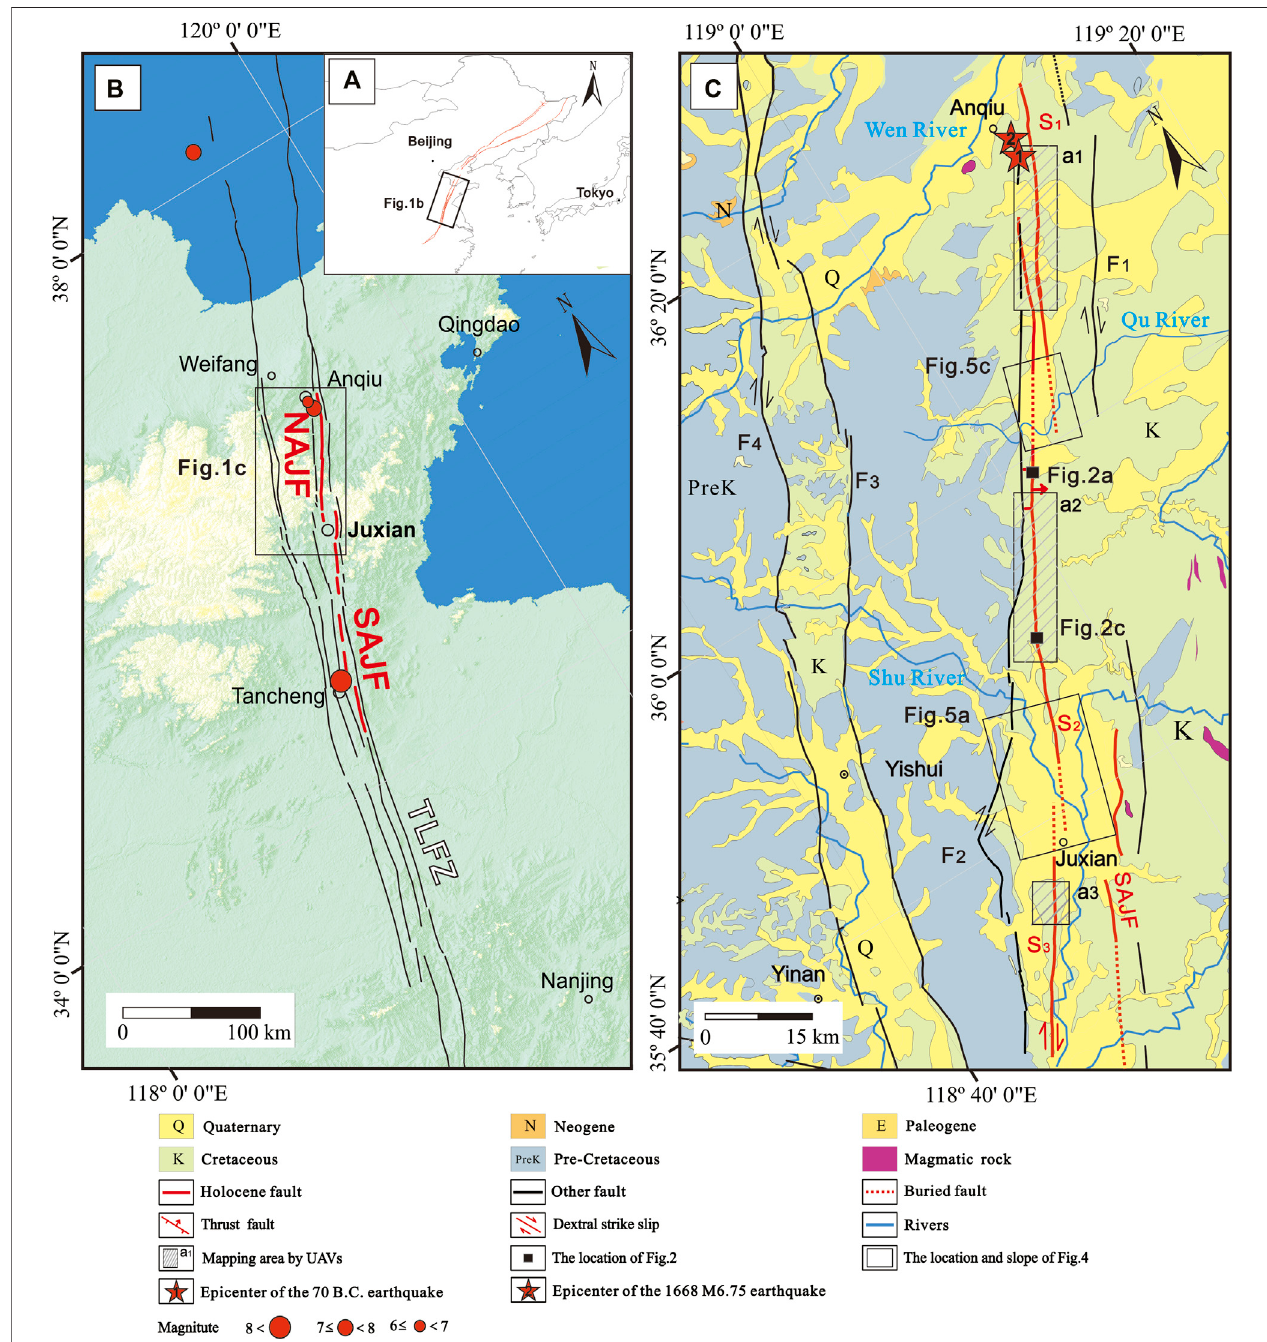
FIGURE1|(A) :GeographicallocationmapoftheTan – LuFaultZone.Theblackrectangleshowsthelocationof (B) . (B) :GeologicalmapoftheAnqiu – JuxianFault. The black rectangle shows the location of the geological map in (C) . (C) : Geological map of the northern segment of the Anqiu – Juxian Fault. The black boxes show the locations of Figures 5A,C . Abbreviations for fault names: TLFZ, Tan – Lu Fault Zone; NAJF, Northern Anqiu – Juxian Fault; SAJF, Southern Anqiu – Juxian Fault; F1, Changyi – DadianFault;F2,Baifenzi – FulaishanFault;F3,Yishui – TangtouFault;F4,Tangwu – GegouFault;S1-S3:threesubsegmentsoftheNAJF,whicharedivided by the Wen River, the Shu River and the Qu River